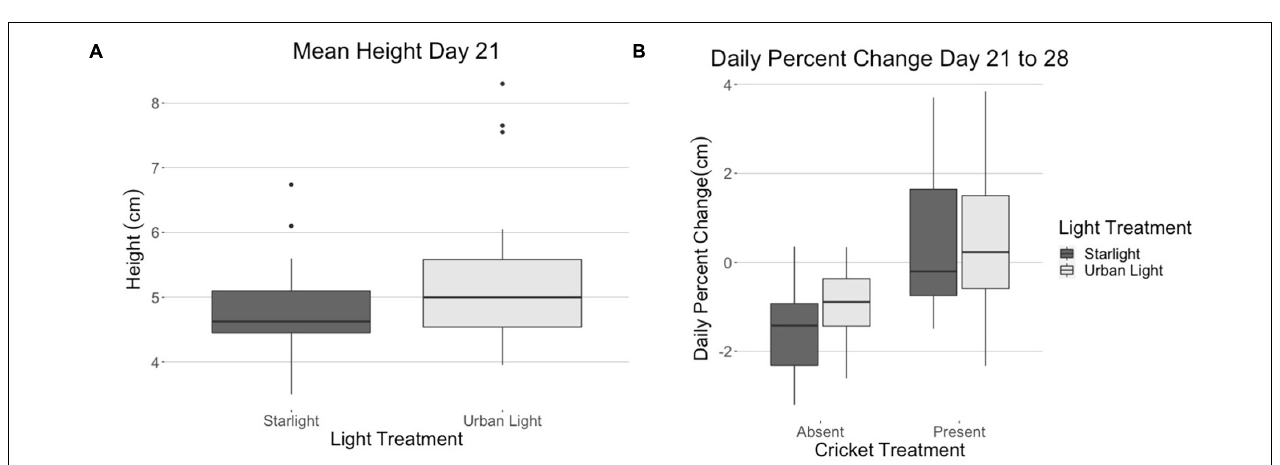
FIGURE 2 | (A) Net photosynthesis across light treatments, measured under low light conditions (10 µ mols m - 2 s - 1 of light) and (B) stomatal conductance across light treatments. (C) Photosystem II efficiency is measured using a saturating pulse ( (cid:56) PSII): (cid:56) PSII = (Fm’ - Fs)/Fm’ where Fm is chlorophyll fluorescence under low light. (D) Dark respiration measured in complete darkness. There were no differences in net photosynthesis, stomatal conductance, photosystem II efficiency, or dark respiration between light treatments.